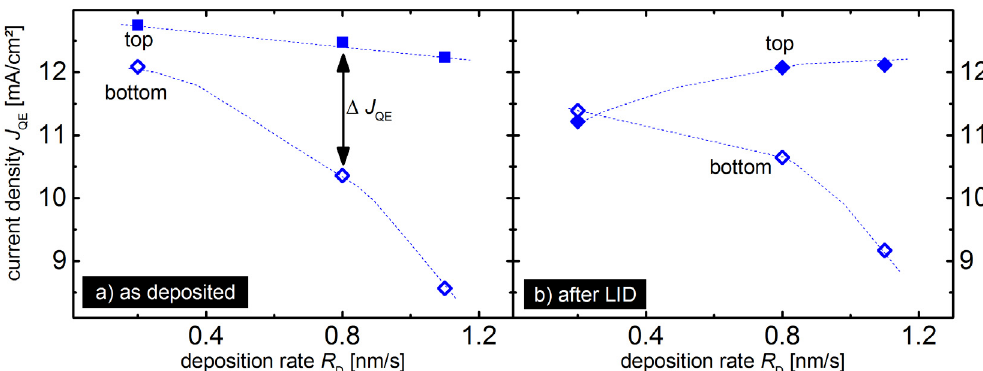
Fig. 3. Current density J QE of the top and the bottom solar cells, derived from EQE measurements, as a function of deposition rate R D before (a) and after (b) 1000 h of light induced degradation.